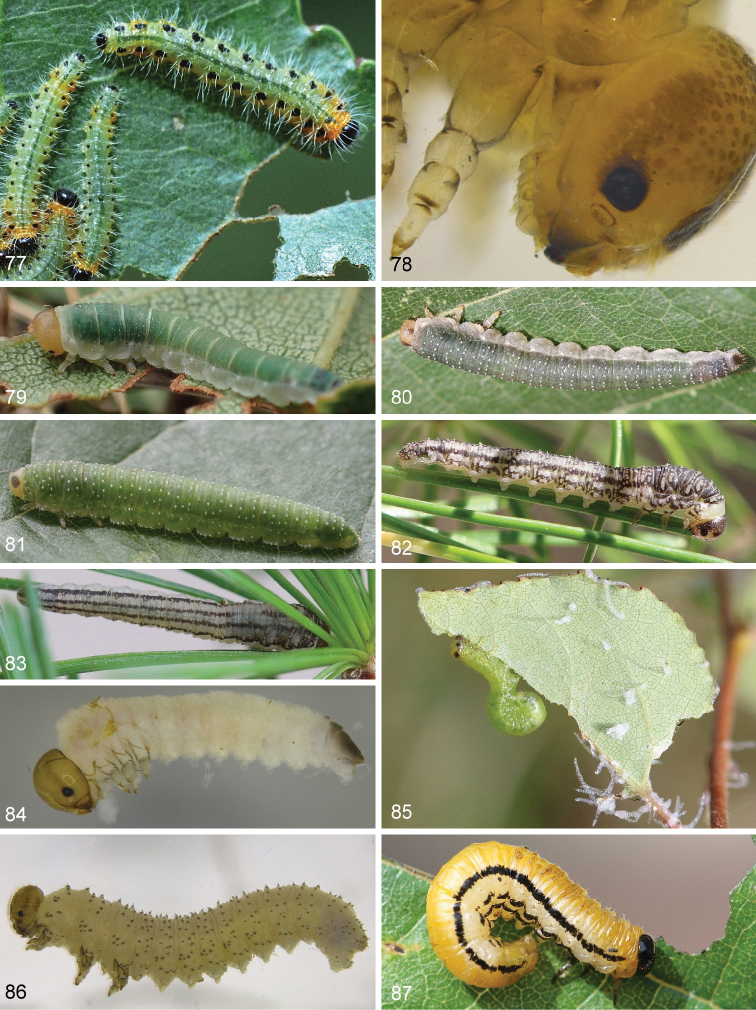
Larvae of Nematinae77Cladius
grandis78Euura
sp.
amentorum group 79Nematinus
acuminatus80Nematinus
luteus81Nematinus
steini82–83Anoplonyx
albitarsis84Hoplocampa
crataegi85Stauronematus
platycerus86Pristiphora
malaisei from Potentilla
fruticosa87Hemichroa
crocea.